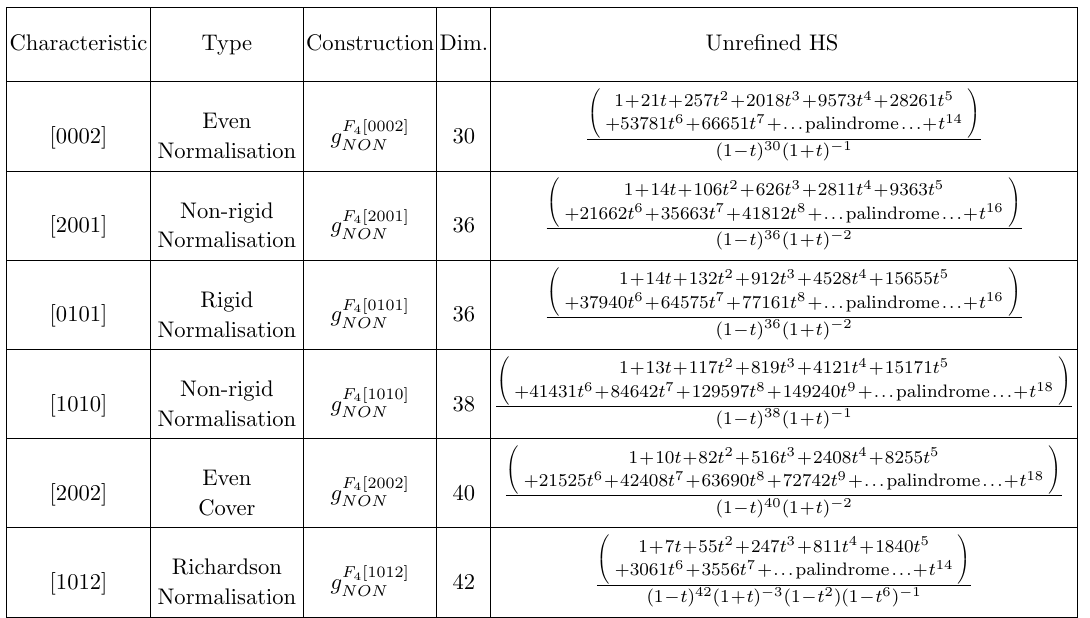
Table 10 . F 4 nilpotent orbit normalisations and Hilbert series. In addition to the normalisations of non-normal nilpotent orbits, the extension F 4 [2002] is shown (see